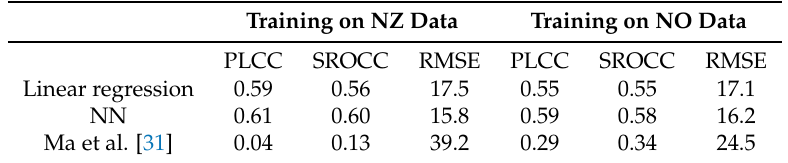
Table 3. Prediction performance of model for ˆ T i (training on one group of participants, testing on the